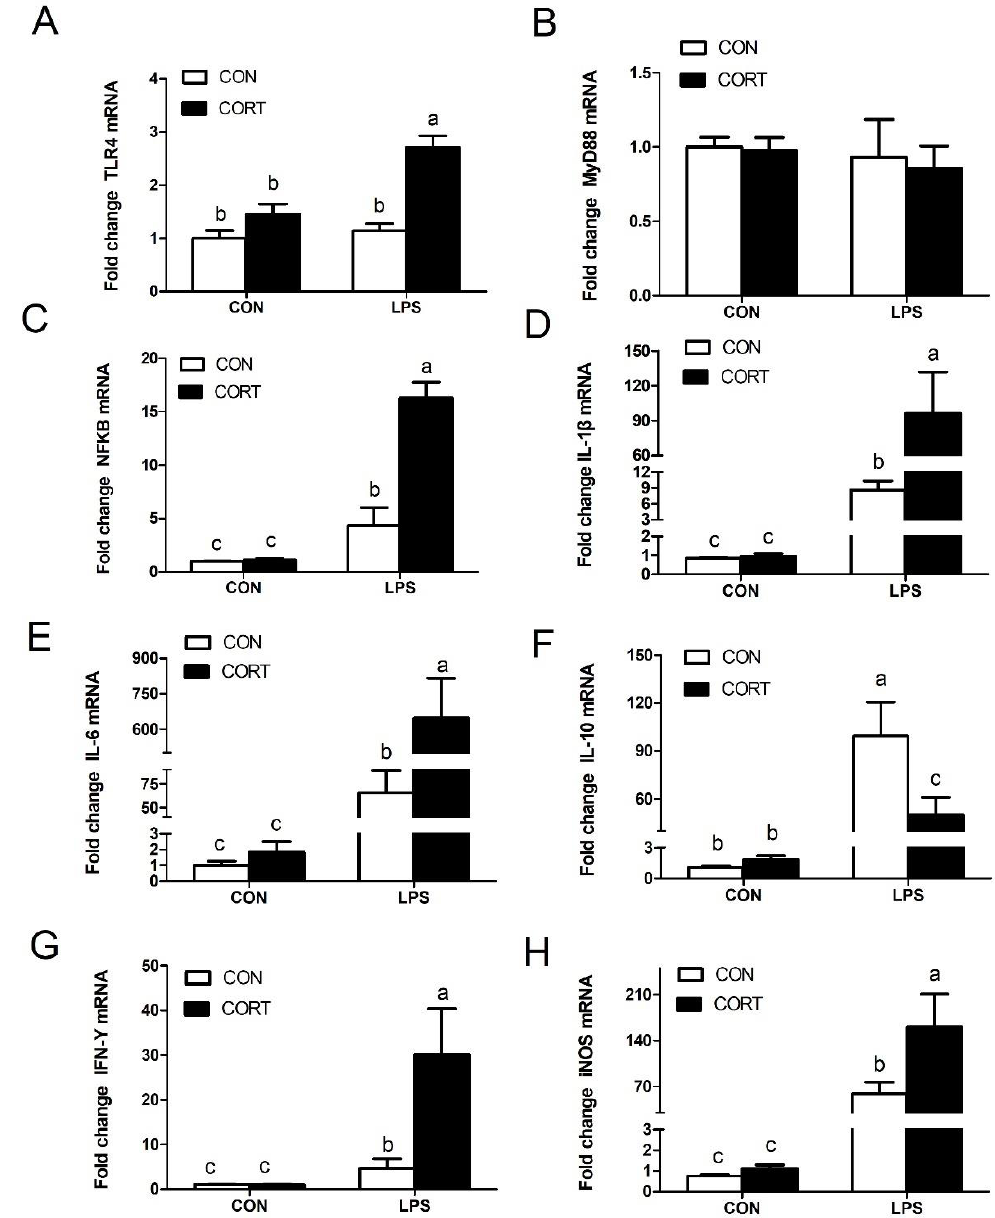
Figure 5. Expression of hepatic genes related to inflammation. ( A ) Hepatic TLR4 mRNA expression. ( B ) Hepatic MyD88 mRNA expression. ( C ) Hepatic NF κ B mRNA expression. ( D ) Hepatic IL-1 β mRNA expression. ( E ) Hepatic IL-6 mRNA expression. ( F ) Hepatic IL-10 mRNA expression. ( G ) Hepatic IFN- γ mRNA expression; ( H ) Hepatic iNOS mRNA expression. C-CON, control group; C-CORT, corticosterone-treated group; L-CON, LPS-treated group; L-CORT, LPS- and corticosterone-treated group; Data were normalized to the expression of the 18S rRNA gene and are presented as means ± SEM (n = 8). a–c Means with di ff erent small letter superscripts are significantly di ff erent ( p < 0.05).